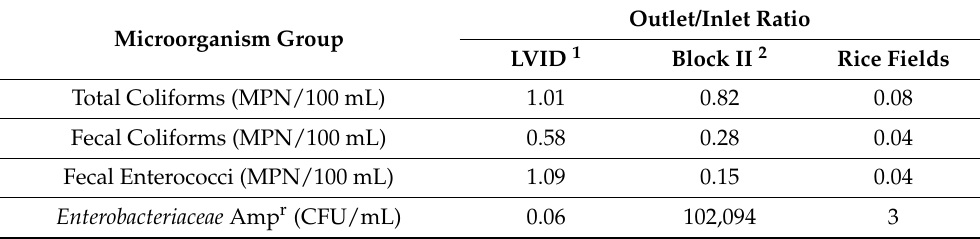
Table 2. Ratio of the mean values of Total Coliforms, Fecal Coliforms, Fecal Enterococci and Enter- obacteriaceae Amp r counts at the outlet and inlet of the: LVID; Block II; rice fields of Block